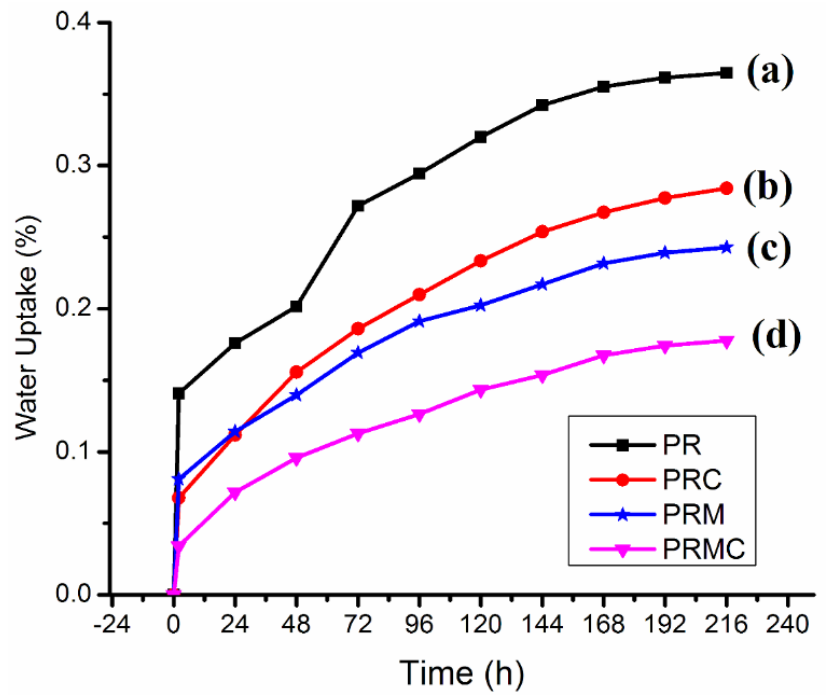
Figure 4. Water uptake of different composites: ( a ) PR, ( b ) PRC, ( c ) PRM, and ( d ) PRMC.